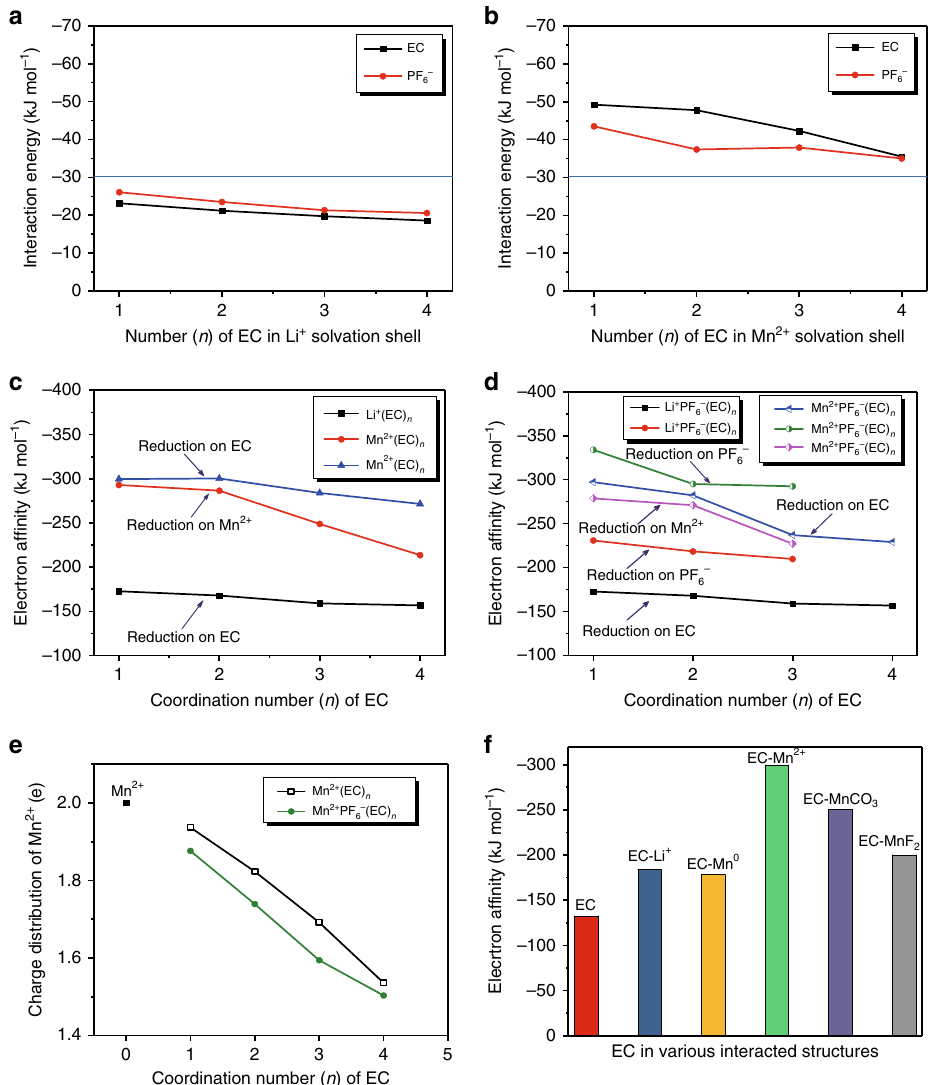
Fig. 3 Interaction energy and reduction activity of Mn 2 + species. Interaction energy of EC solvent and PF 6 − with Li + ( a ) and Mn 2 + ( b ); Electron af fi nity energy of Li + and Mn 2 + solvation shells with ( c ) and without ( d ) PF 6 − ; Charge distribution of Mn 2 + in solvation shells ( e ); Electron af fi nity energy of EC in various interacted structures ( f